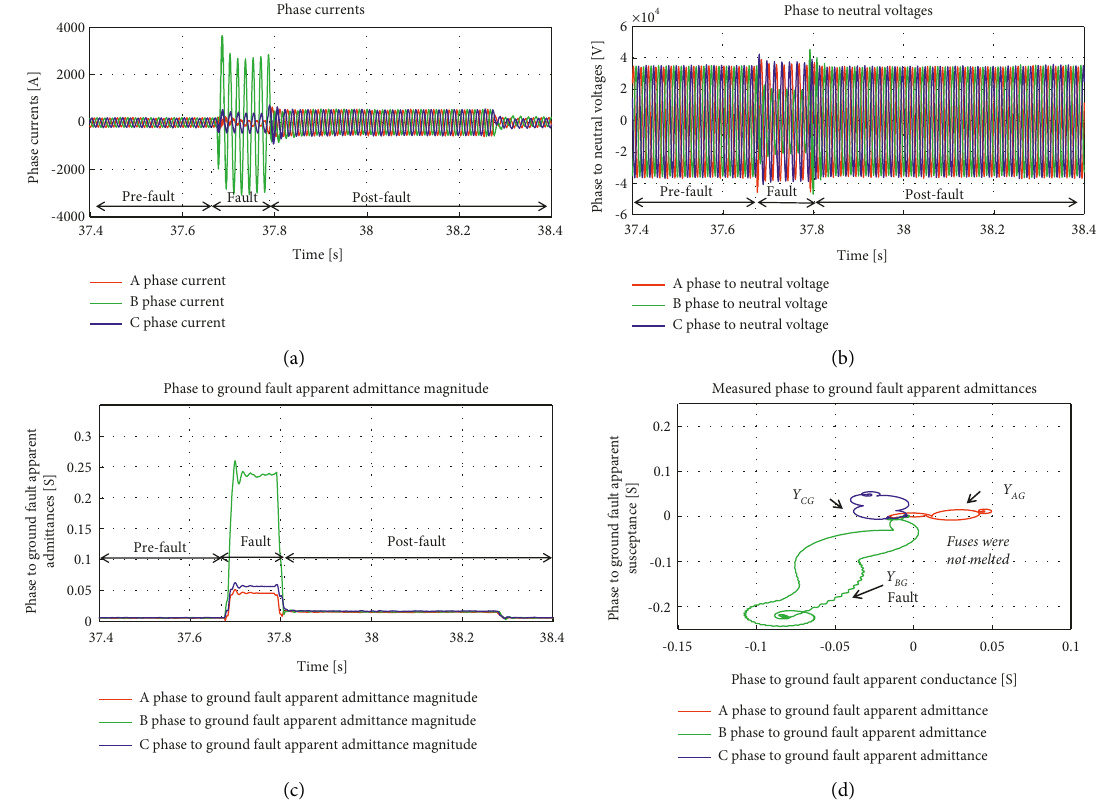
Figure 12: SIGID-934 event (a) currents, (b) voltages, (c) PGFA admittance magnitudes, and (d) PGFA conductance/susceptance from the optical power line sensors deployed on the